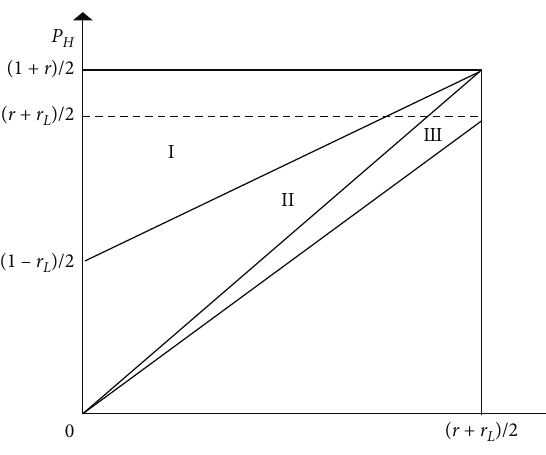
Figure 2: Actual market demand for fresh food.